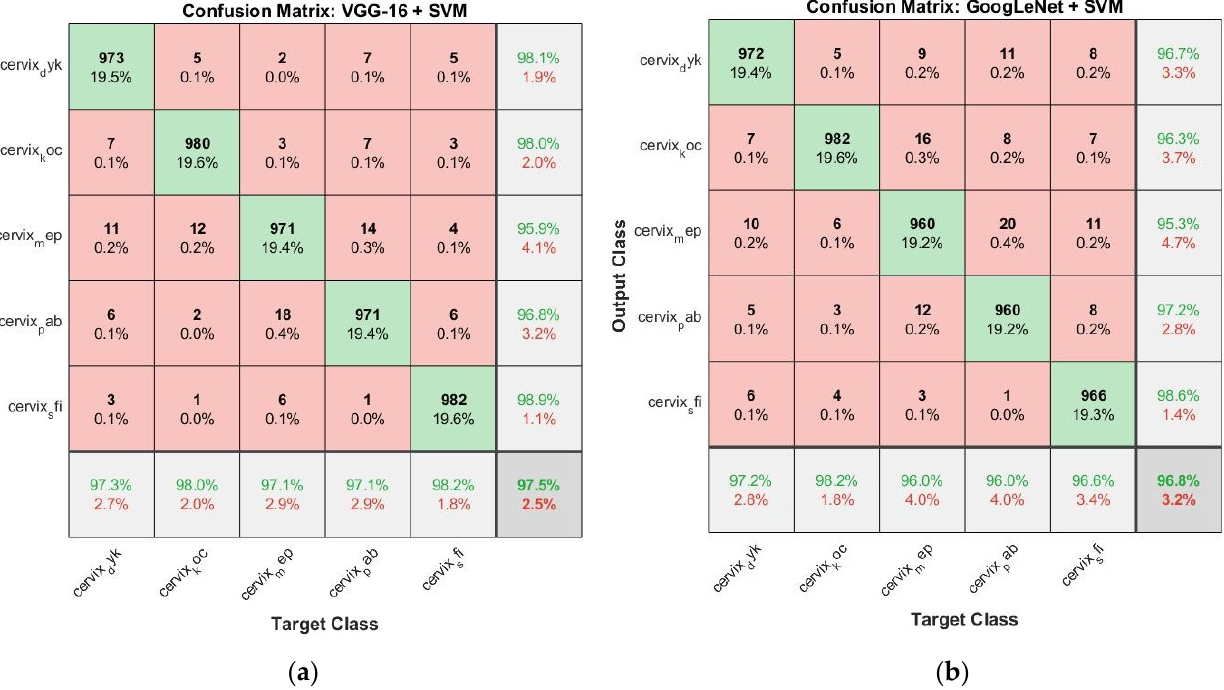
Figure 8. Results of the diagnosis of WSIs of abnormal cells of the cervix by ( a ). VGG-16 + SVM and ( b ). GoogLeNet + SVM.